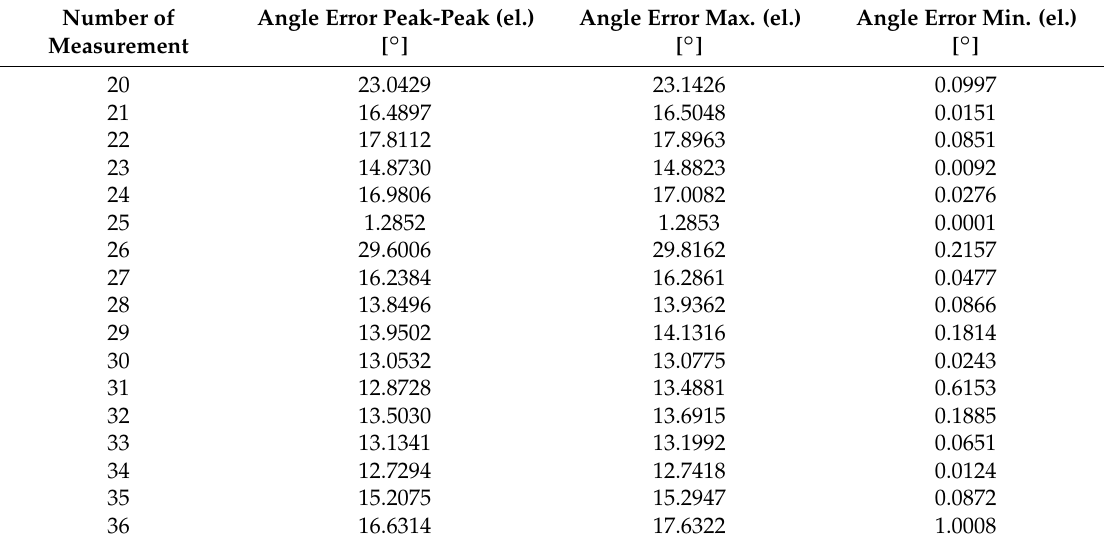
Table 1. Exemplary table of the automatically calculated evaluation parameters, supporting angle error tolerances